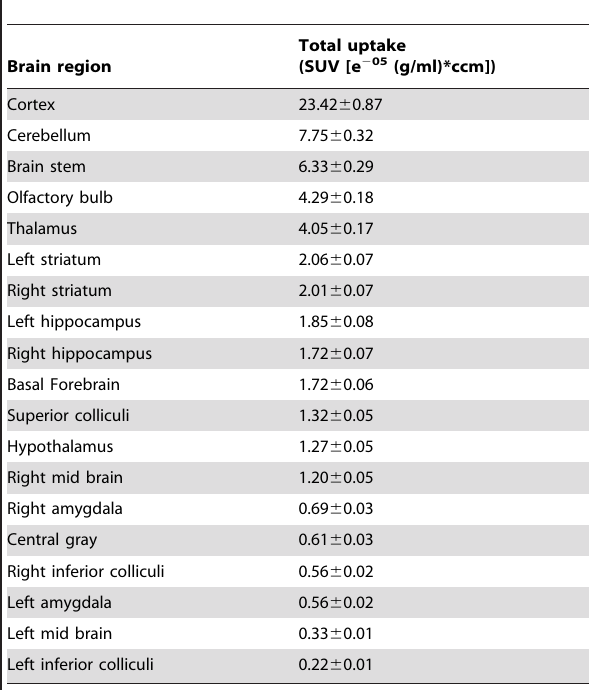
Table 1. Total 18 F-FDG uptake in brain regions.